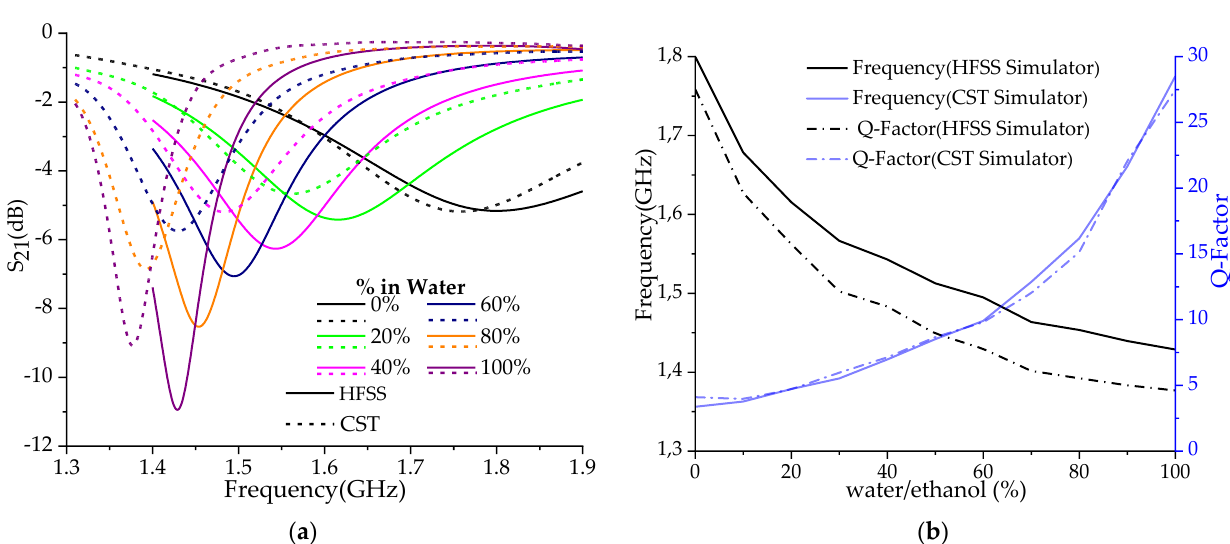
Figure 13. Simulated results: ( a ) S 21 response and ( b ) resonant frequency and Q factor for different mixture water concentrations, with r = 5 mm.